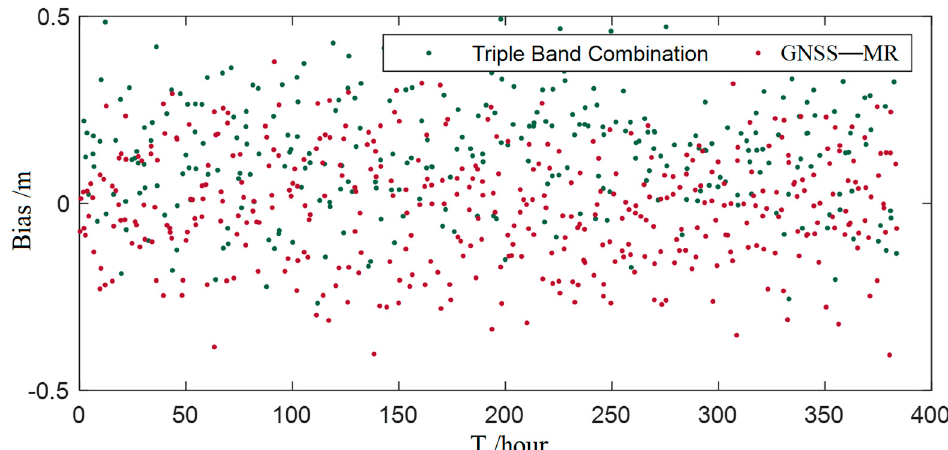
Figure 7. The inversion of the tide level by the triple-frequency combined tidal tide-inversion method and GNSS-MR, respectively. Bias represents the difference between the inversion tide point value and the measured tide point value of the tide detector; the abscissa T indicates the time of the tide level inversion.